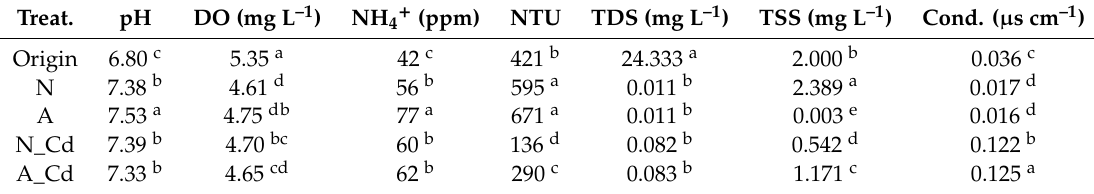
Table 1. Hydrographical and chemical characteristics of stream waters during leaf immersion and decomposition in